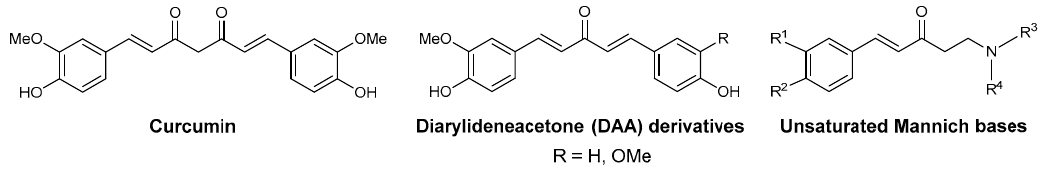
Figure 1. Structures of natural curcumin and diarylideneacetone (DAA) derivatives that have been identified in Curcuma extracts and the structure of the related unsaturated ketonic Mannich bases.